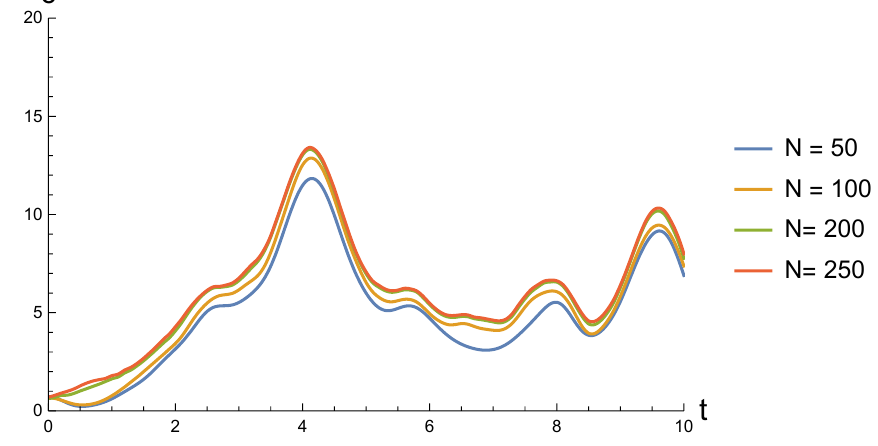
Figure 7: The time development of the commutator squared value shown for different truncation.